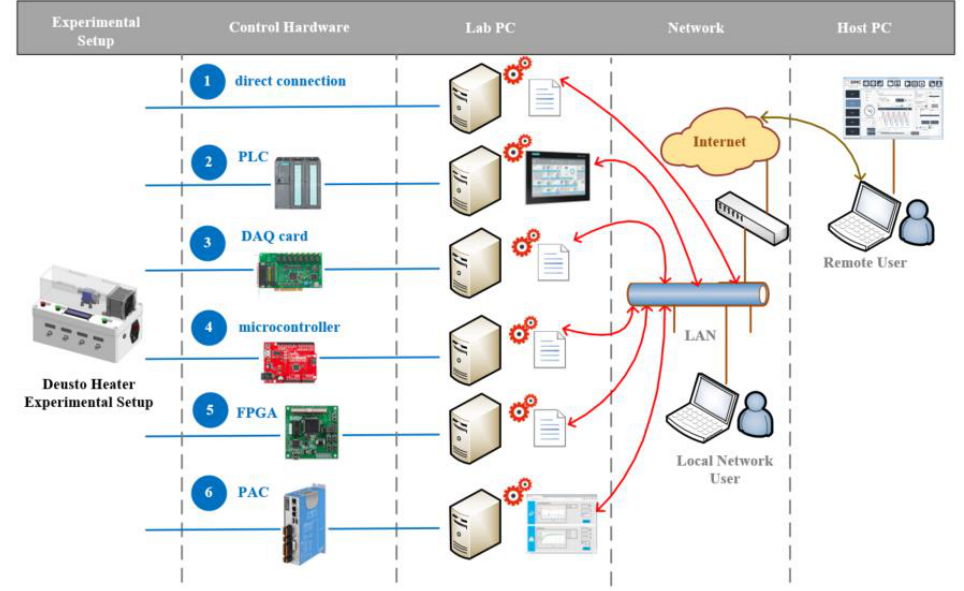
Figure 3. Review of the most frequently approaches to control hardware applied in industry.